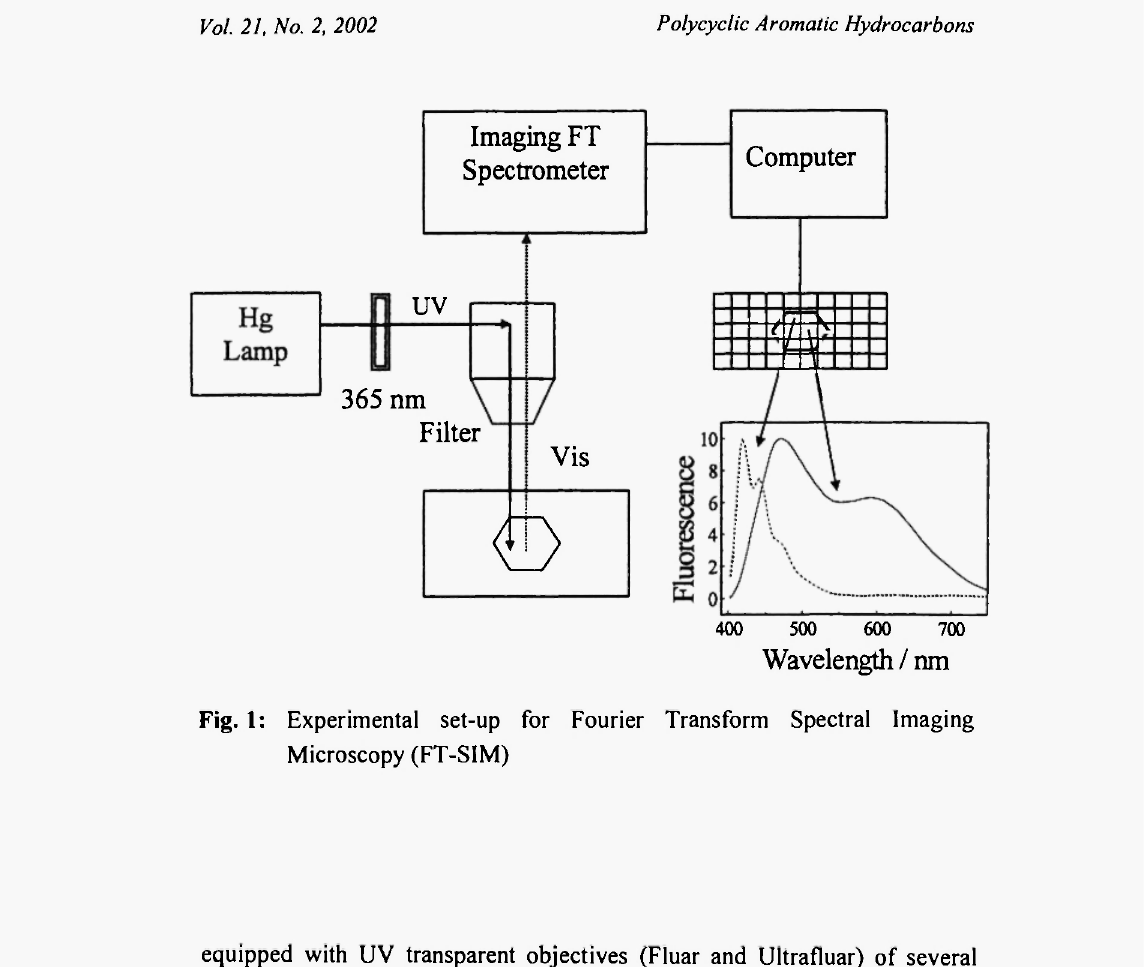
Fig. 1: Experimental set-up for Fourier Transform Spectral Imaging Microscopy